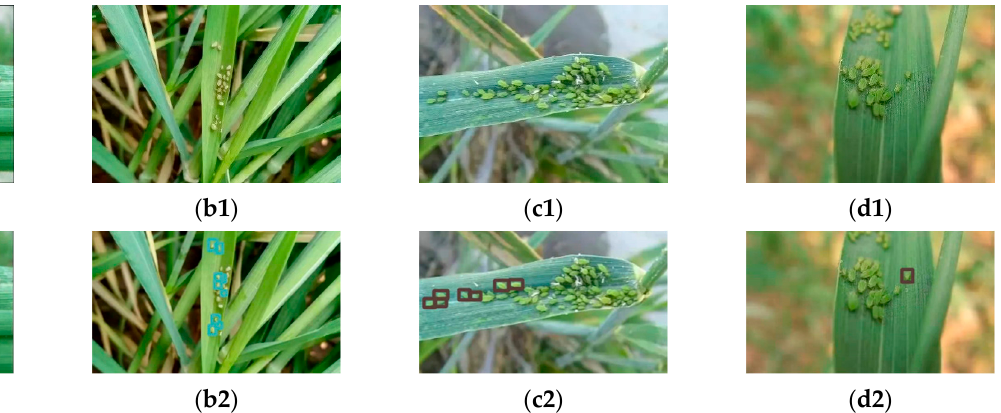
Figure 9. Wheat aphid. ( a1 ), ( b1 ), ( c1 ), and ( d1 ) are the original images; ( a2 ), ( b2 ), ( c2 ), and ( d2 ) are the recognition results.